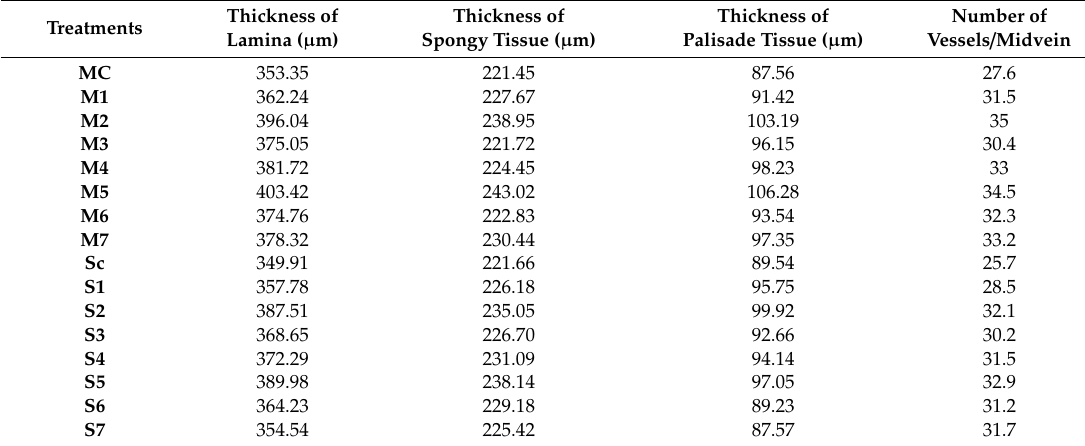
Table 9. E ff ect of spent mushroom substrate extract (SMSE), mushroom culture filtrate (MCF), and Roundup ® treatments to control broomrape infestation on anatomical characters of infested faba bean leaves (leaflet) with broomrape.